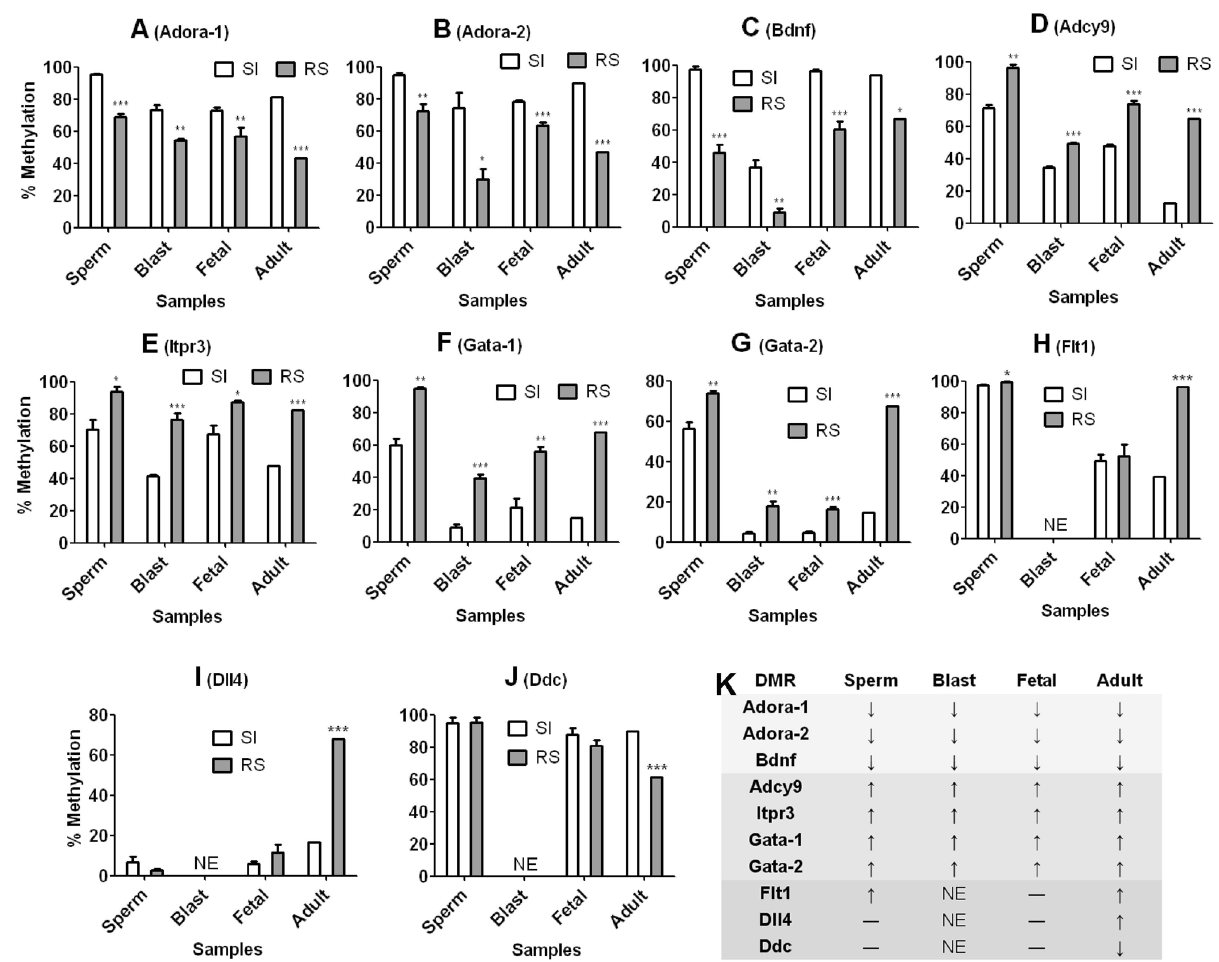
Figure 6. Bisulfite sequencing for the DMR methylation status of candidate CAT genes in F0 sperm and F1 blastocysts, fetal and adult hippocampi of the RS/SI model. Each treatment was repeated at least three times and each replicate contained spermatozoa, blastocysts or fetal hippocampi recovered from one mouse. Data were analyzed using Independent-Samples T Test. Graphs A to J show percentages of methylated CpGs. *, ** and *** indicates significant difference from SI samples at P < 0.05, 0.01 and 0.001 levels, respectively. Graph K summarizes methylation trends in RS samples relative to SI samples of different genes from sperm to blastocysts to fetal and adult hippocampi. Data for adult hippocampi were obtained from our WGBS (Dataset S8). Adora-1 and -2 Adora2a-DMR1 and -DMR2, Gata-1 and -2 Gata2-DMR1 and -DMR2, ‘ ↓ ’: lower methylation, ‘ ↑ ’: higher methylation, ‘—’: insignificant difference, NE not